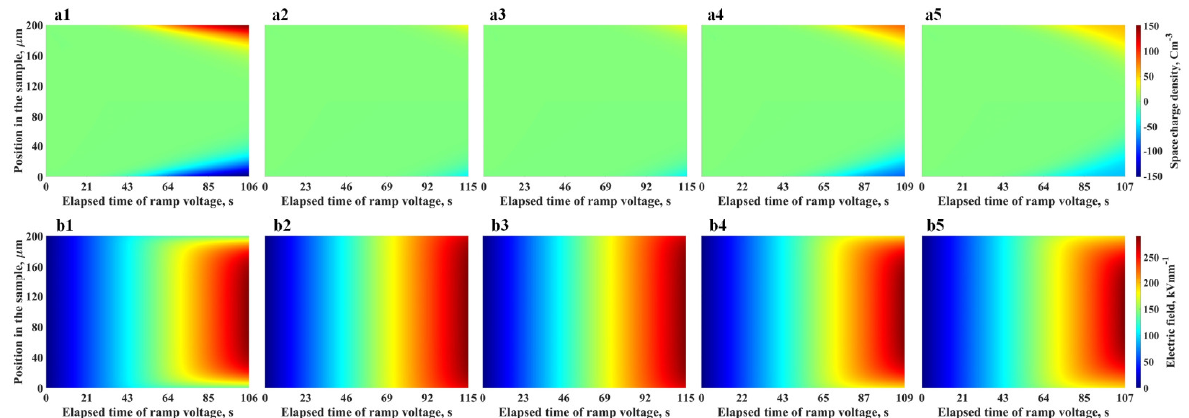
Figure 4. Distributions of space charges ( a1 – a5 ) and electric fields ( b1 – b5 ) in pure LDPE and LDPE/Al 2 O 3 nanodielectrics with nanofiller contents of 0.1 wt%, 0.5 wt%, 2.0 wt%, and 5.0 wt%.